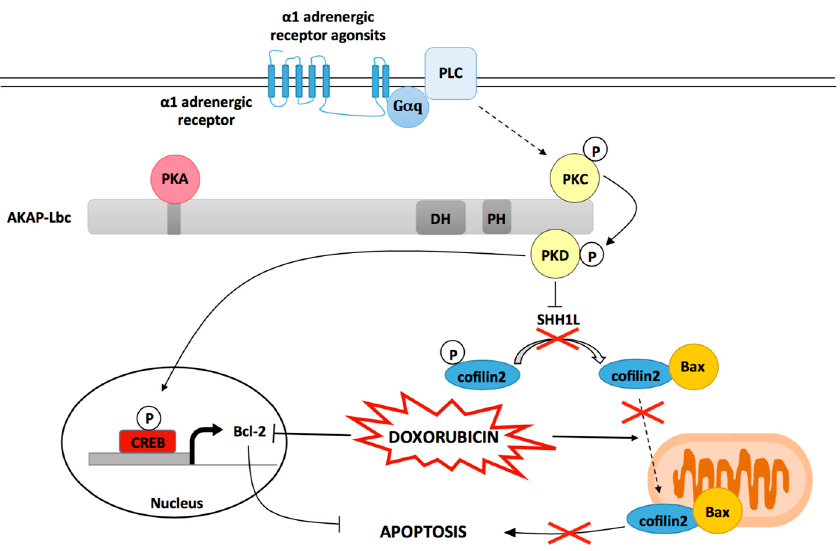
Figure 2. The role of AKAP-Lbc in mediating protection against Dox induced cardiomyocyte toxicity. Scaffolding of PKD by AKAP-Lbc facilitates α 1-AR-mediated PKD1 activation resulting in the phosphorylation and inactivation of the phosphatase SSH1L. As a consequence, phosphorylated cofilin2 accumulates and remains sequestrated in the cytoplasm. This inhibits Dox-induced translocation of cofilin2/Bax complexes to mitochondria, and subsequent mitochondrial dysfunction and apoptosis. Activated PKD1 also favors cAMP regulatory element binding protein (CREB)-mediated transcriptional activation of the antiapoptotic gene Bcl-2 otherwise down regulated by Dox treatment.